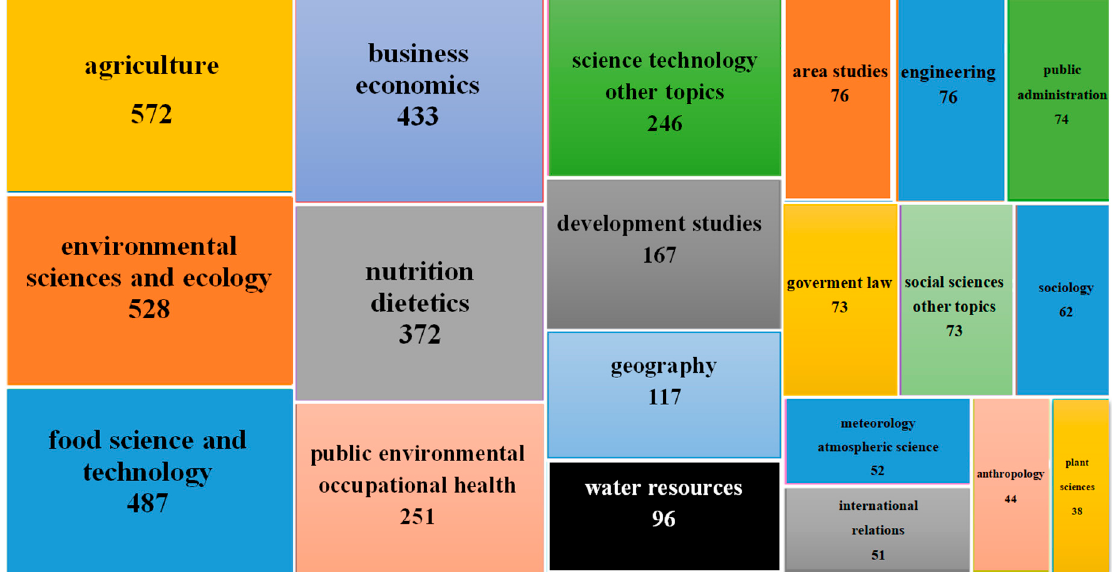
Figure 5. Discipline distribution of food security research.